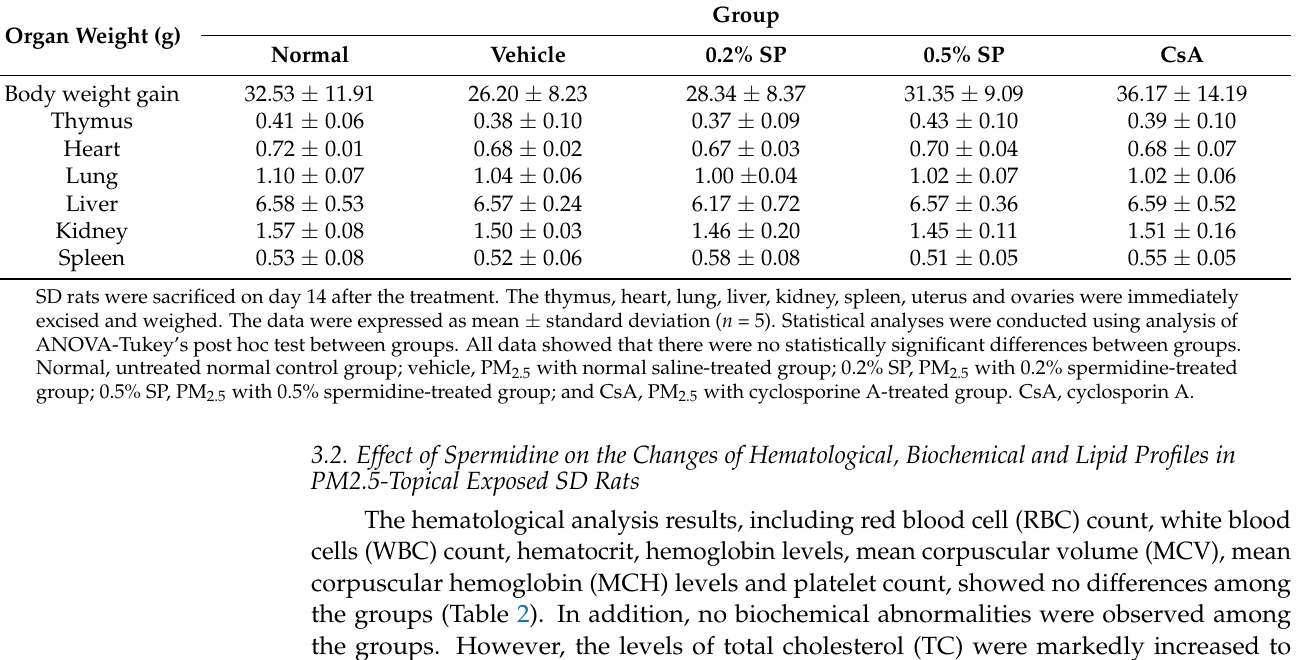
Table 1. Changes in the weight of organs after 2 weeks of treatment in PM 2.5 -topical exposed Sprague-Dawley rats. Organ Weight